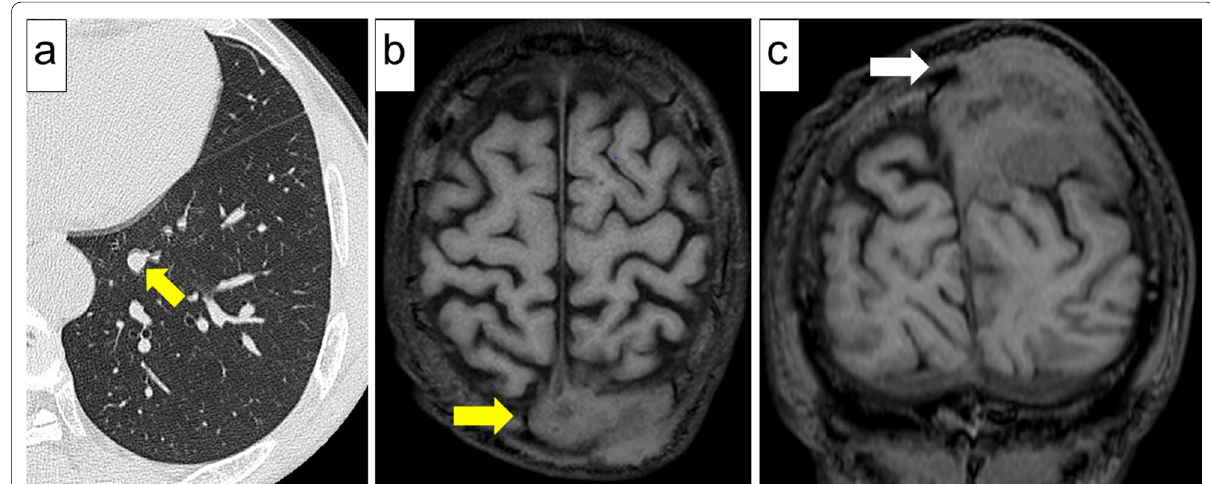
Fig. 1 Medical imaging findings. a Computed tomography of the chest showing a 10-mm solitary pulmonary nodule in the left lower lobe of the lung (yellow arrow). b Two years before the referral, magnetic resonance imaging revealing a 65-mm tumor in the left parietal region (yellow arrow, axial section) and c skull infiltration of the tumor (white arrow, coronal section)